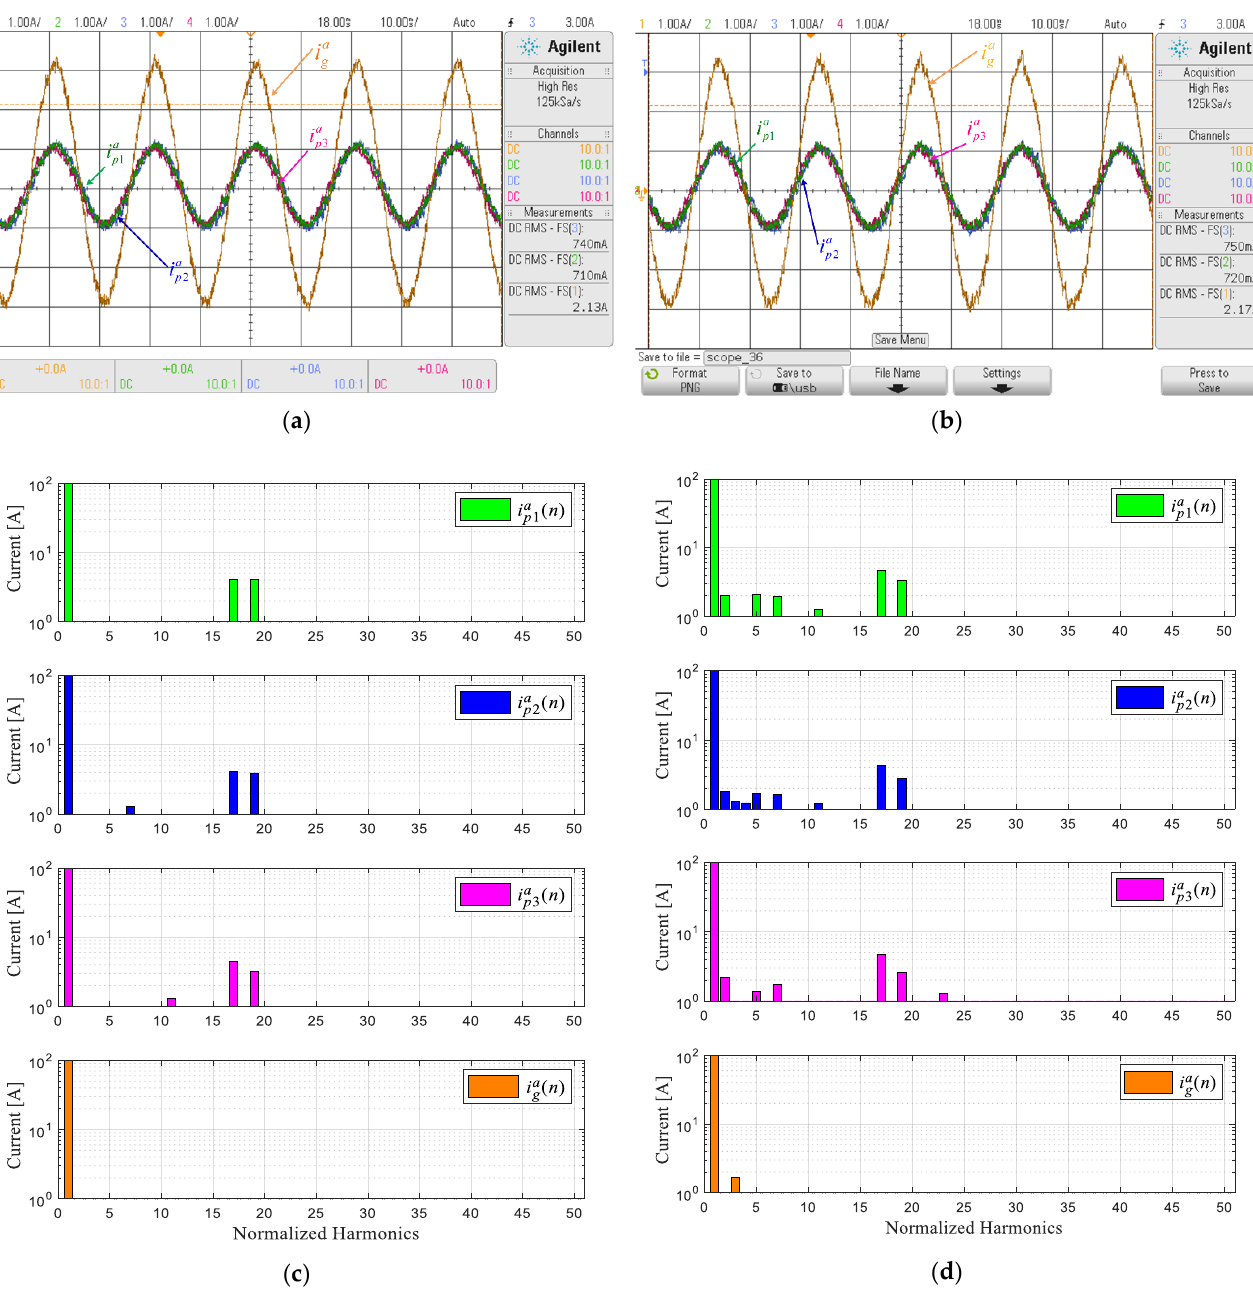
Figure 8. Experimental results input çurrent loop. ( a ) Input current phase a in each AFE rectifier and input current multicell AFE rectifier for k sw = 0.00, ( b ) input current phase a in each AFE rectifier and input current multicell AFE rectifier for k sw = 0.12, ( c ) harmonic spectrum input current phase a in each AFE rectifier and input current multicell AFE rectifier for k sw = 0.00, ( d ) harmonic spectrum input current phase a in each AFE rectifier and input current multicell AFE rectifier for k sw = 0.12.